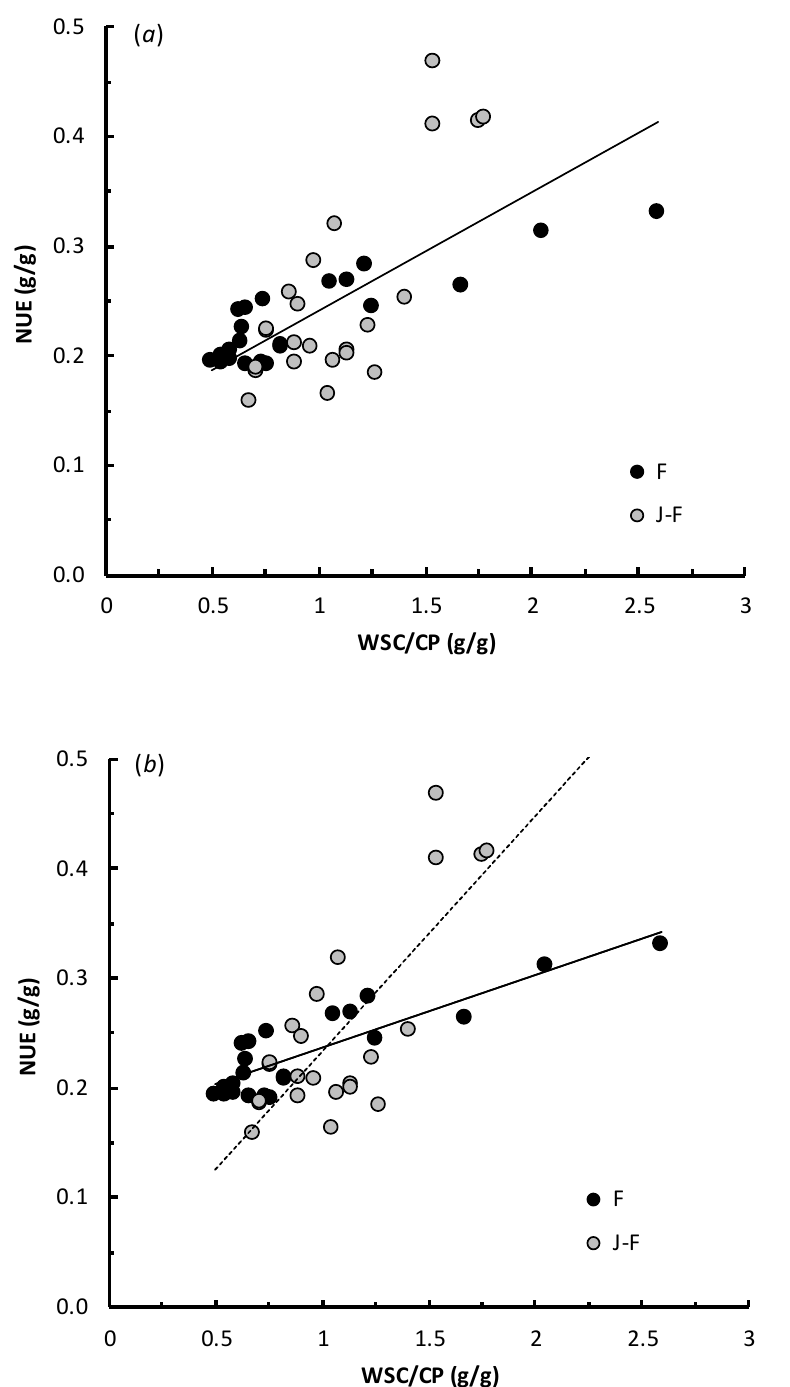
Figure 1. Linear relationships between NUE and dietary WSC/CP ratio for groups of ryegrass-fed Friesian (N = 22) and Jersey × Friesian (N = 23) cows: ( a ) shows the overall line of best fit (Model 7; Table 6) and ( b ) shows separate regression models for both breeds (Models 8 and 9; Table 6).